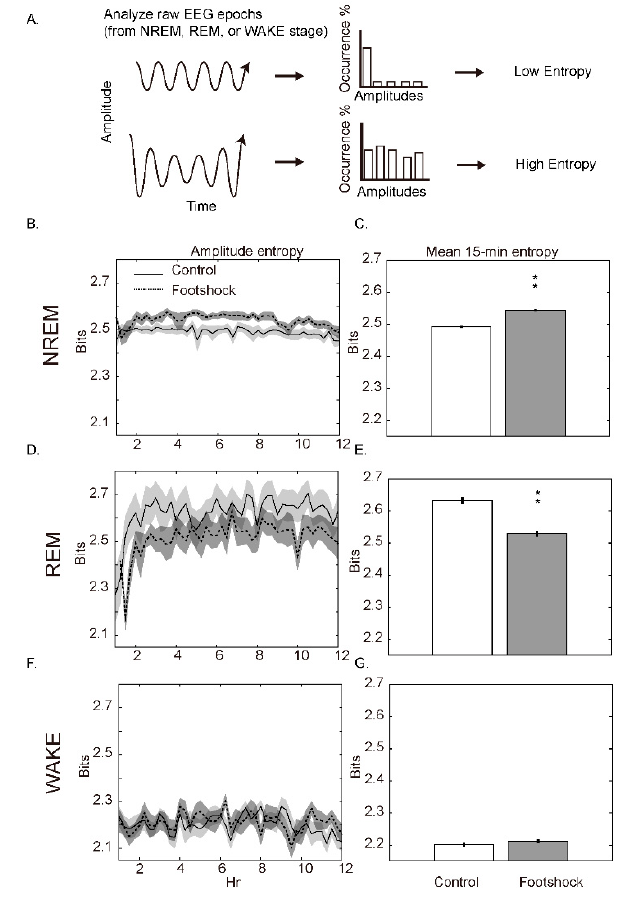
Figure 3. Comparison of the amplitude entropy after the footshock stimuli. ( A ) Uniform amplitudes of EEGs result in a low entropy, whereas the variety of amplitudes causes uncertainty of occurrence rate and results in a high entropy. ( B ) Distribution of amplitude entropy for NREM sleep. The solid line and light gray shadow are the values of means ± SEMs for every 15 min during the light period, obtained from the control group. The dashed line and dark gray shadow are results acquired from the footshock group. ( C ) Statistical significant test for the amplitude entropy. The white bar represents the value of mean ± SEM for 15 min bins across the total 12 h light period, obtained from the control group, and the gray bar depicts the amplitude entropy acquired from the footshock group. ( D , E ) Represented the data of REM sleep. ( F , G ) Demonstrated the results for the wakefulness. ** Indicates the difference reaches statistical significance of p < 0.01.